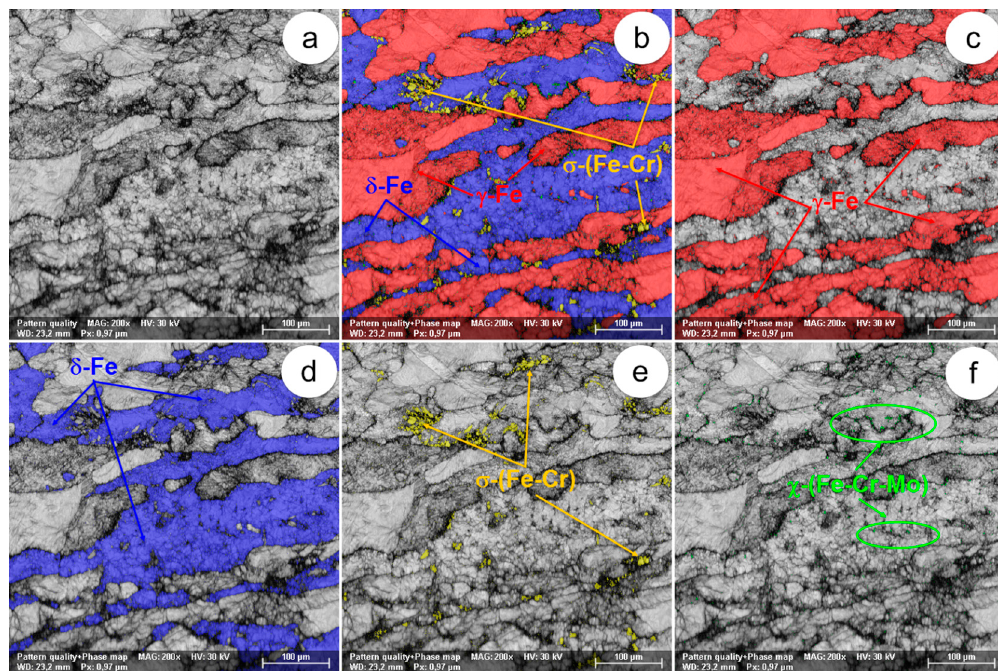
Figure 6. The SEM-EBSD composite images (×200) obtained after forging at 850 °C: ( a ) the microstructure of the analysed field; ( b ) the distribution of existing phases in the microstructure of the analysed field; ( c ) the distribution of the γ -Fe phase; ( d ) the distribution of the δ -Fe phase; ( e ) the distribution of the σ -(Fe-Cr) phase; ( f ) the distribution of the χ -(Fe-Cr-Mo) phase.